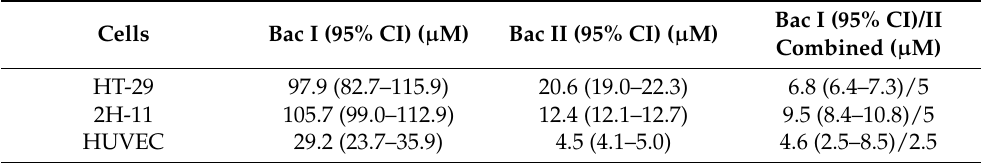
Table 1. The IC 50 of bac I and II alone and combined for HT-29, 2H-11 and